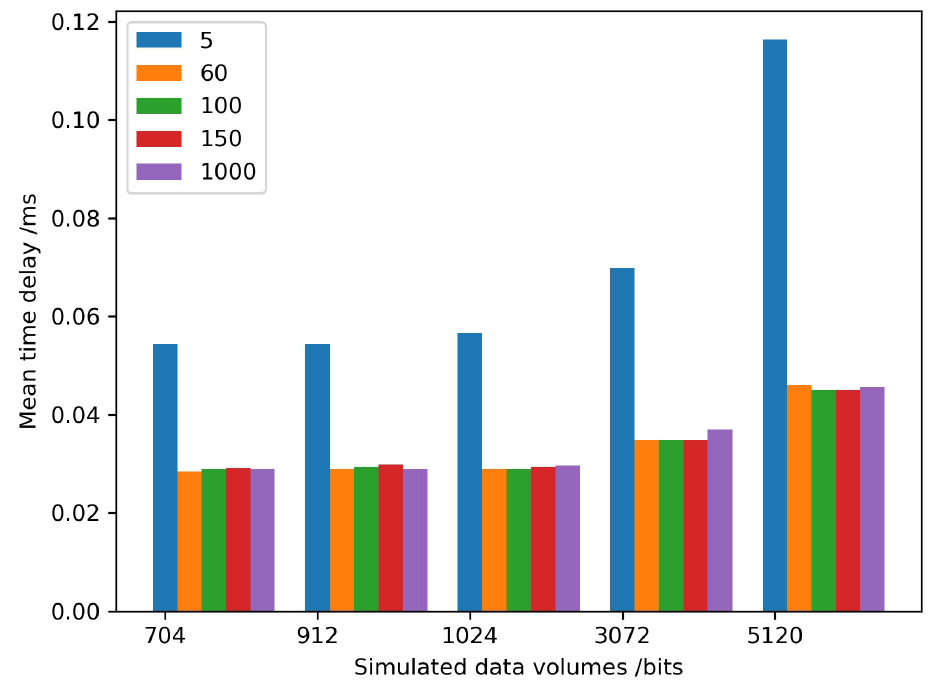
Figure 10. Decryption time delays of different simulated data volumes/bit.